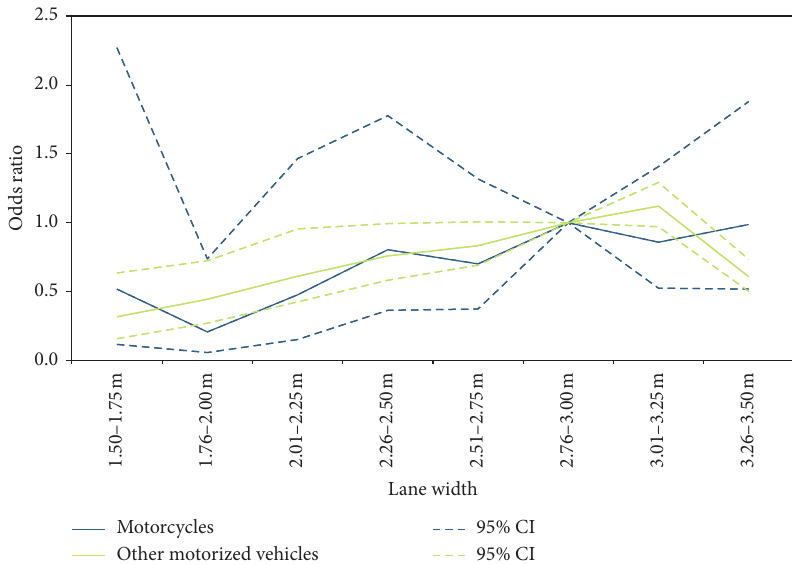
Figure 5: Odds ratio for lane widths. Motorcycles and other motorized vehicles (including data from [32]).